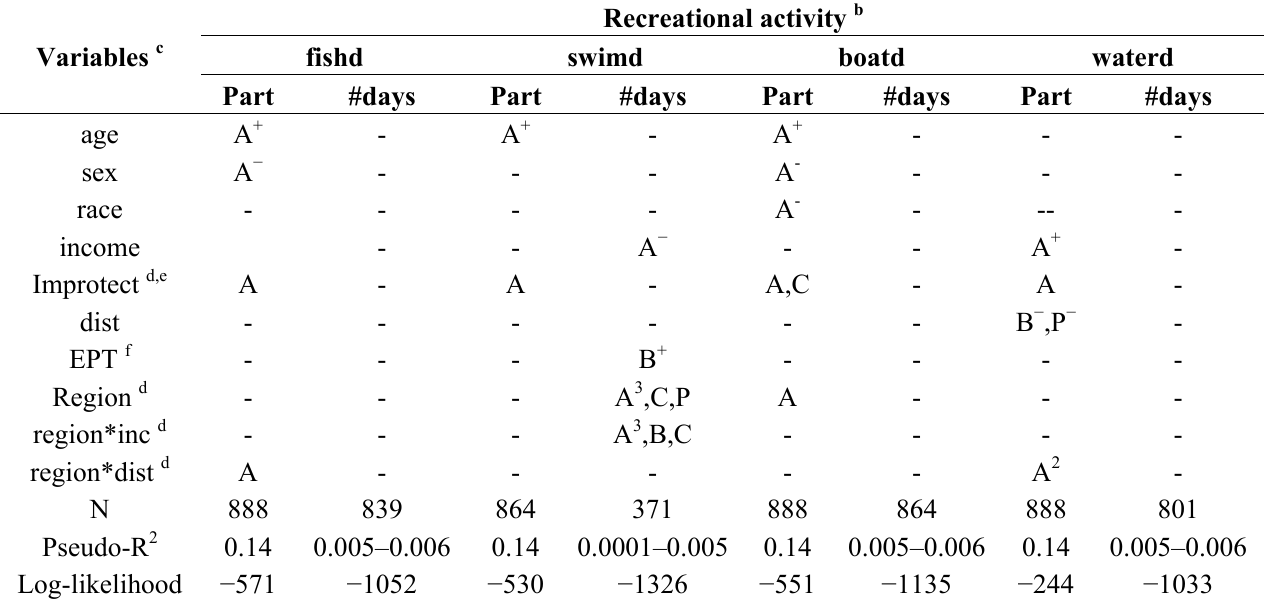
Table 5. CS2: WSA models for which variable is significant at p ≤ 0.05 a . Variables